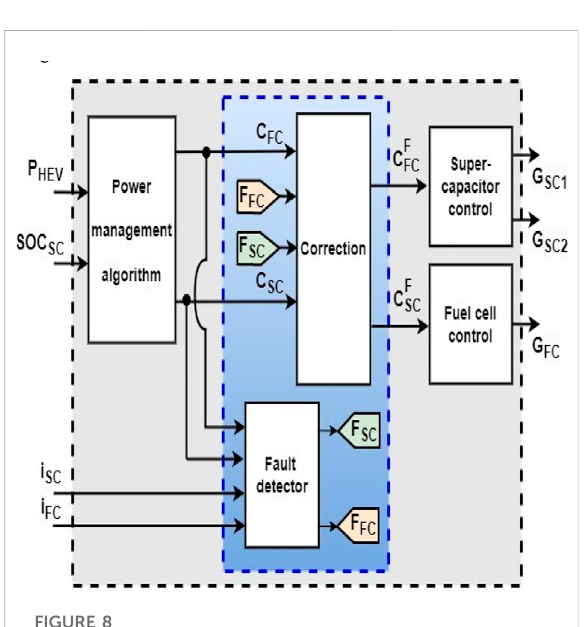
FIGURE 8 Proposed secure power management